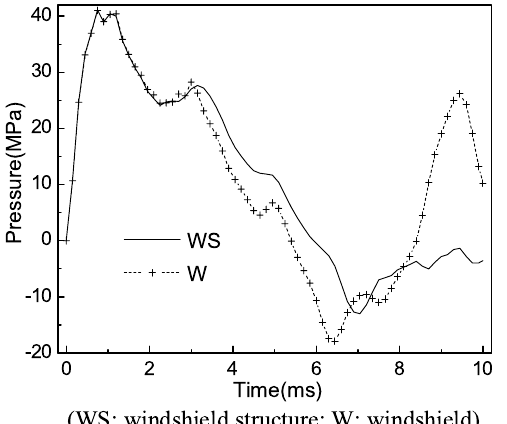
Fig. 26. Time history of pressure at initial strike